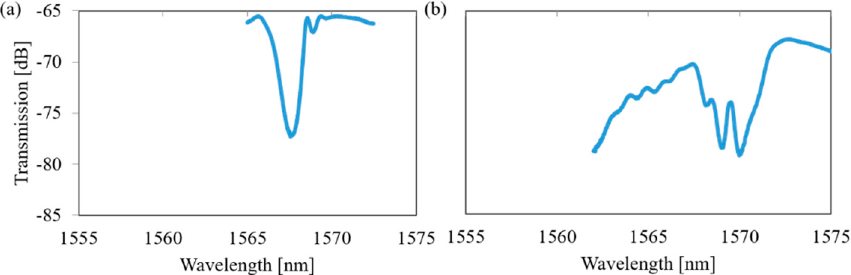
Figure 5. Phase-shifted (PS) FBG fabricated by 325 nm irradiation: ( a ) uniform FBG (first fabrication step), ( b ) PS FBG (Moiré structure based on two overlapped uniform gratings); image adapted from [105].